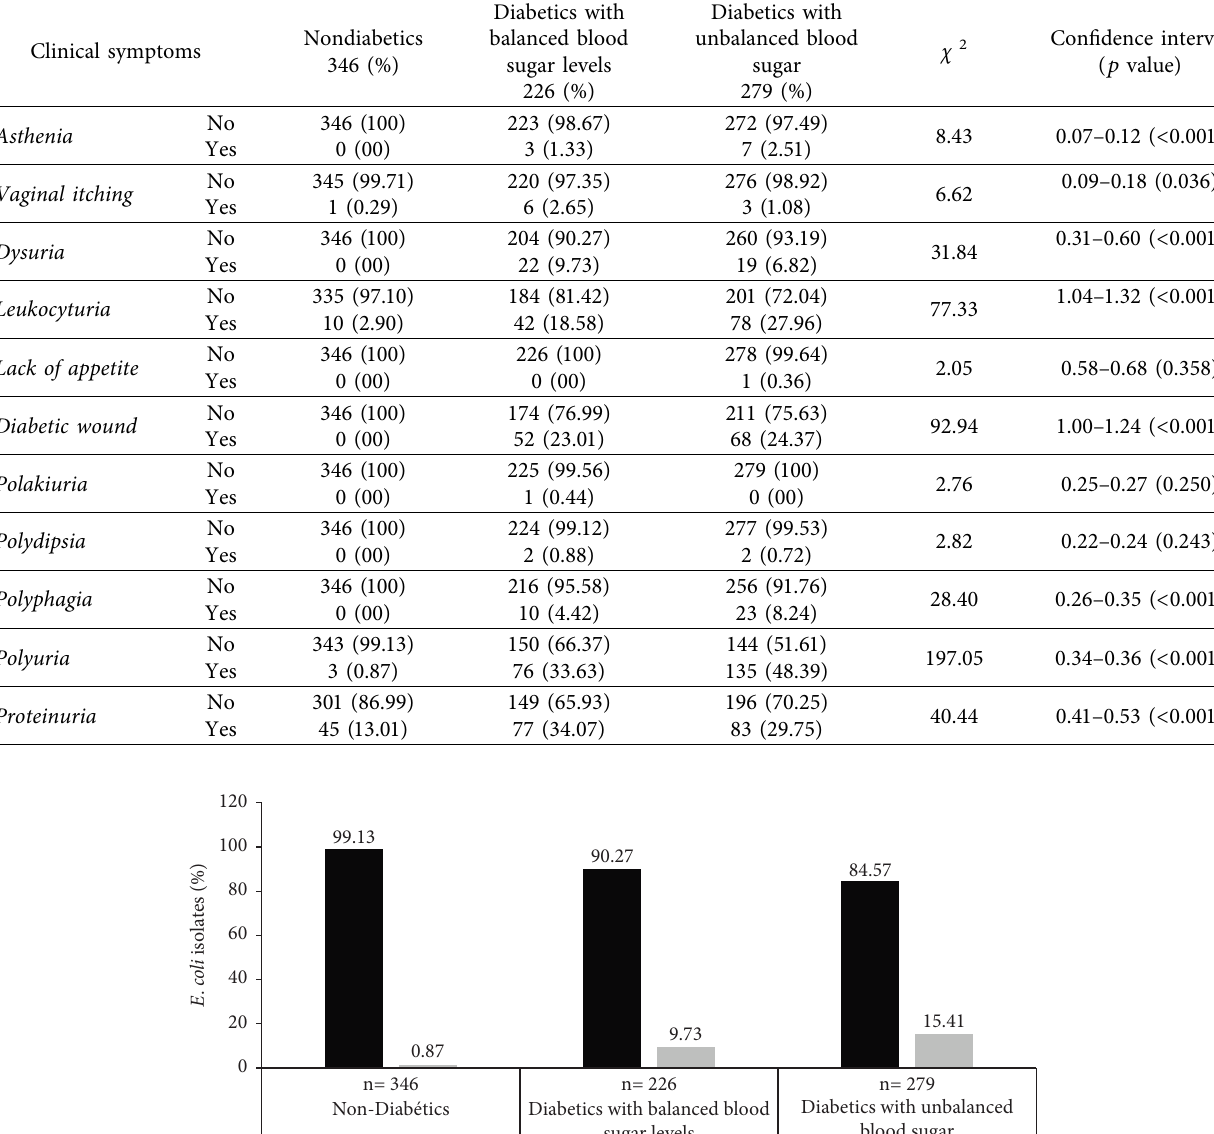
Table 3: Clinical features of the study participants.